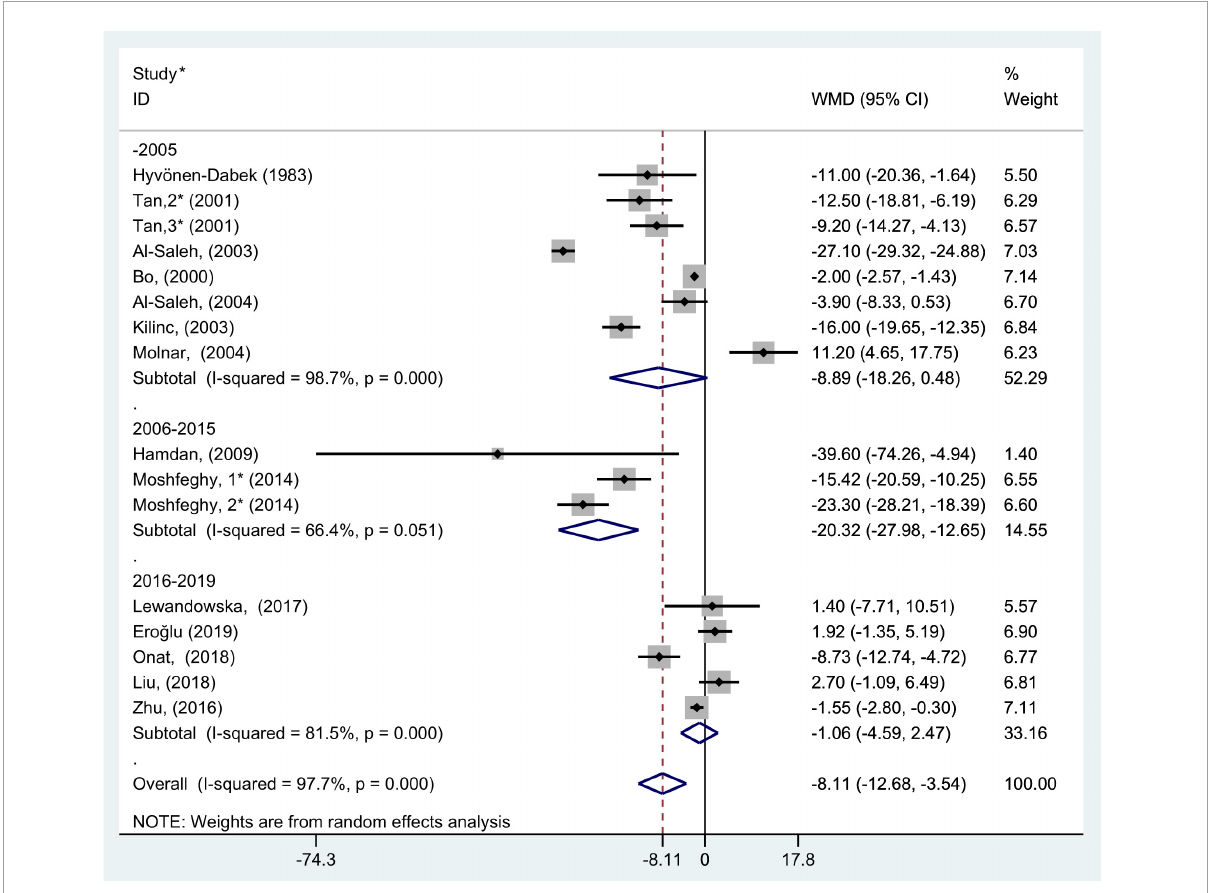
FIGURE6 Subgroup analysis of blood selenium level in patients with gestational diabetes mellitus and healthy pregnant women based on study completion period. The random effect model is applied. For studies in which blood selenium levels were measured during different pregnancy periods in one study, 1, 2, and 3 are used to denote measurements performed in the first, second, and third trimesters, respectively. *First author (year of study completion).